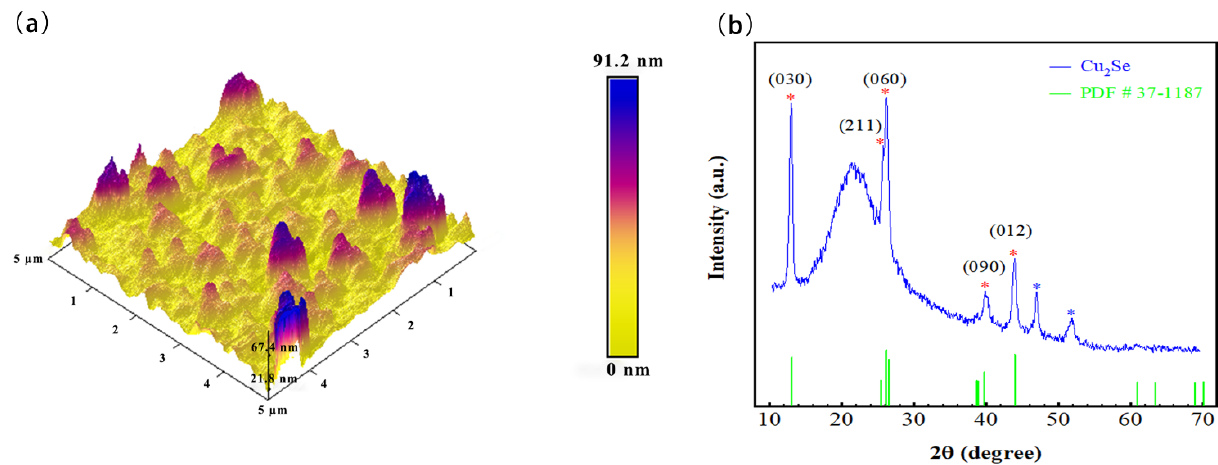
Figure 2. ( a ) Atomic force microscopy (AFM) images of Cu 2 Se. ( b ) X-ray diffraction (XRD) patterns of Cu 2 Se.